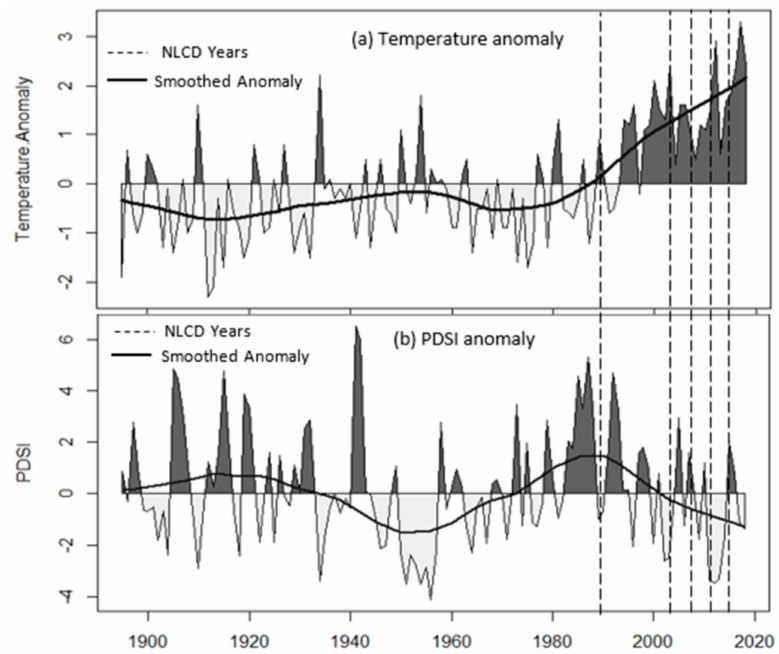
Figure 7. ( a ) Temperature and ( b ) the Palmer Drought Severity Index (PDSI) anomalies over New Mexico (1895–2019) [53] along with the single-date NLCD years (vertical dashed